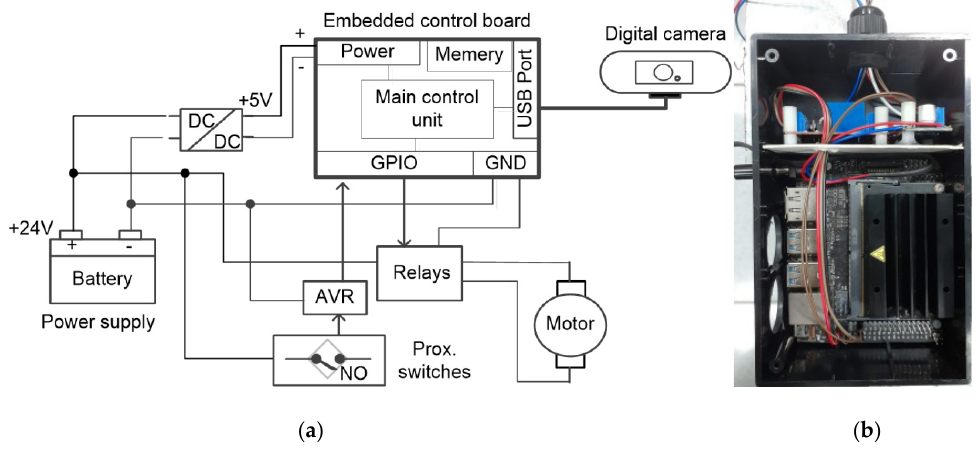
Figure 5. Sensing and circuit architecture: ( a ) Block diagram of electronic circuit and ( b ) peripheral electronic component board (upper layer) and main control board (lower layer) in the control box.